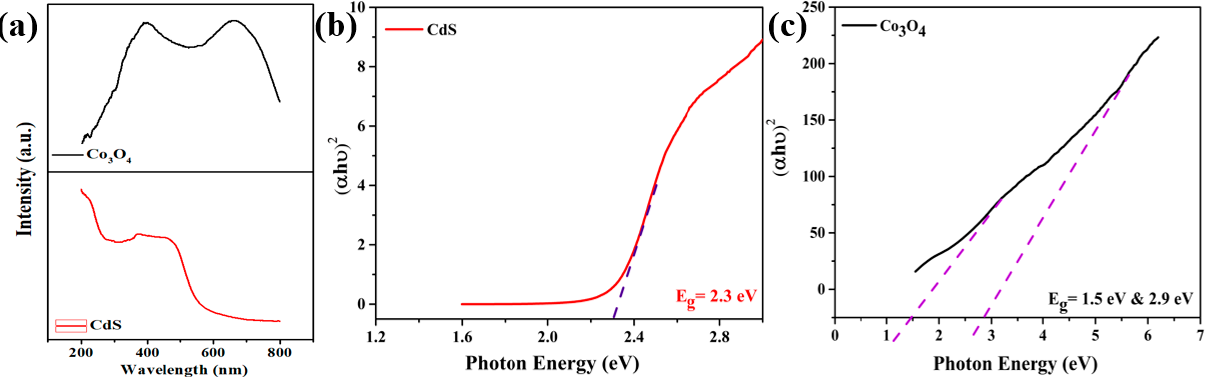
Figure 3. ( a ) UV–Vis spectra of CdS and Co 3 O 4 and the corresponding Tauc plots of ( b ) CdS and ( c ) Co 3 O 4.